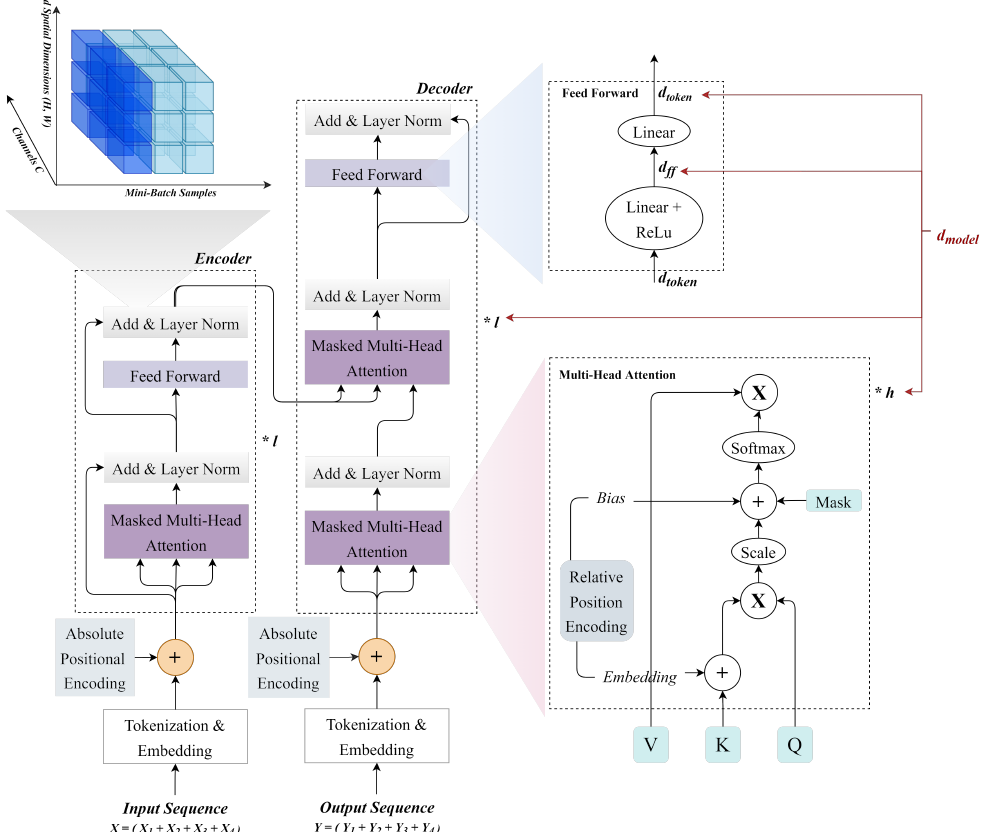
Figure 4. A diagram showing the detailed transformer architecture, which has 2 blocks for the encoder and 3 blocks for the decoder. Attention mechanisms, normalization, and feed-forward layers were the three main concepts on which we focused our attention. In the Feed-forward layer, the number of dimensions in the hidden layer d f f is generally set to around four times that of the token embedding d model . The model size d model = ( l , d token , d f f , h ) where l is the number of encoder/decoder layers, d token is the dimensionality of token embeddings, d f f is the intermediate dimensionality used by the feed-forward sublayer, and h is the number of attention heads in the attention sublayers. The initial Transformer model had a base configuration of l = 6, d token = 512, d f f = 2048, and h =